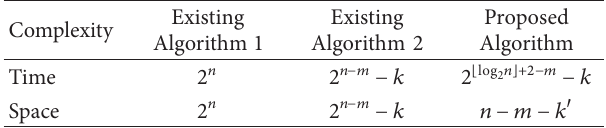
Table 3: Complexities of the proposed algorithm, the existing Algorithm 1, and the existing Algorithm 2.